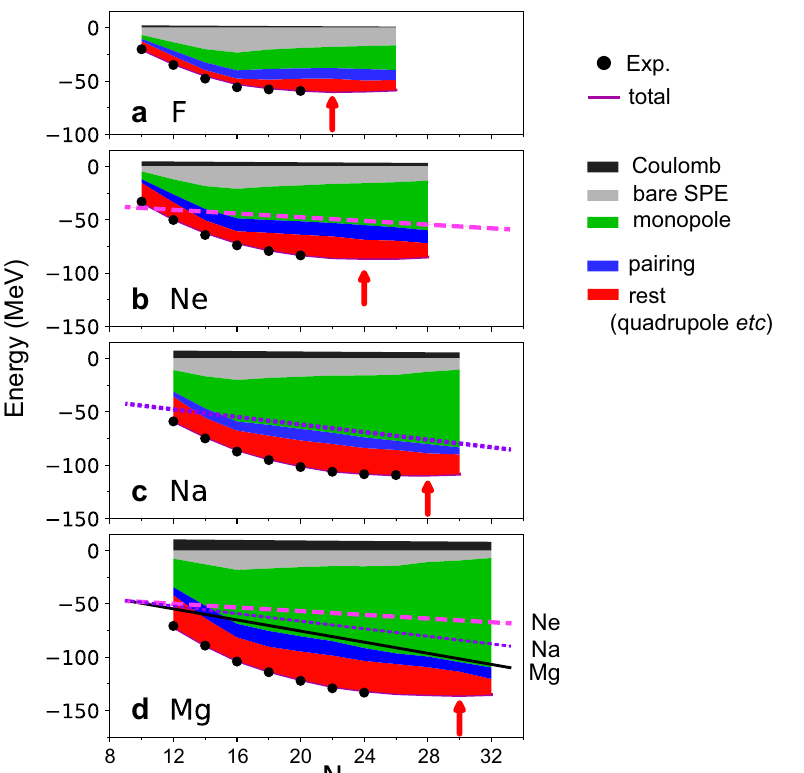
Figure 17. Ground-state energies of even-N isotopes of ( a ) F, ( b ) Ne, ( c ) Na and ( d ) Mg, relative to the 16 O value. Colored segments exhibit decompositions into various effects from the monopole (green), pairing (blue) and rest (such as quadrupole) (red) components of the effective nucleon–nucleon interaction as well as those from Coulomb interaction (black) and single-particle energies (bare SPE; grey). The monopole effect grows steadily as a function of N in all cases, as highlighted by straight lines: dashed (Ne), dotted (Na) and solid (Mg). The experimental values are indicated by black circles [42]. The theoretical driplines indicated by red arrows. Modified from Figure 4 of [57].